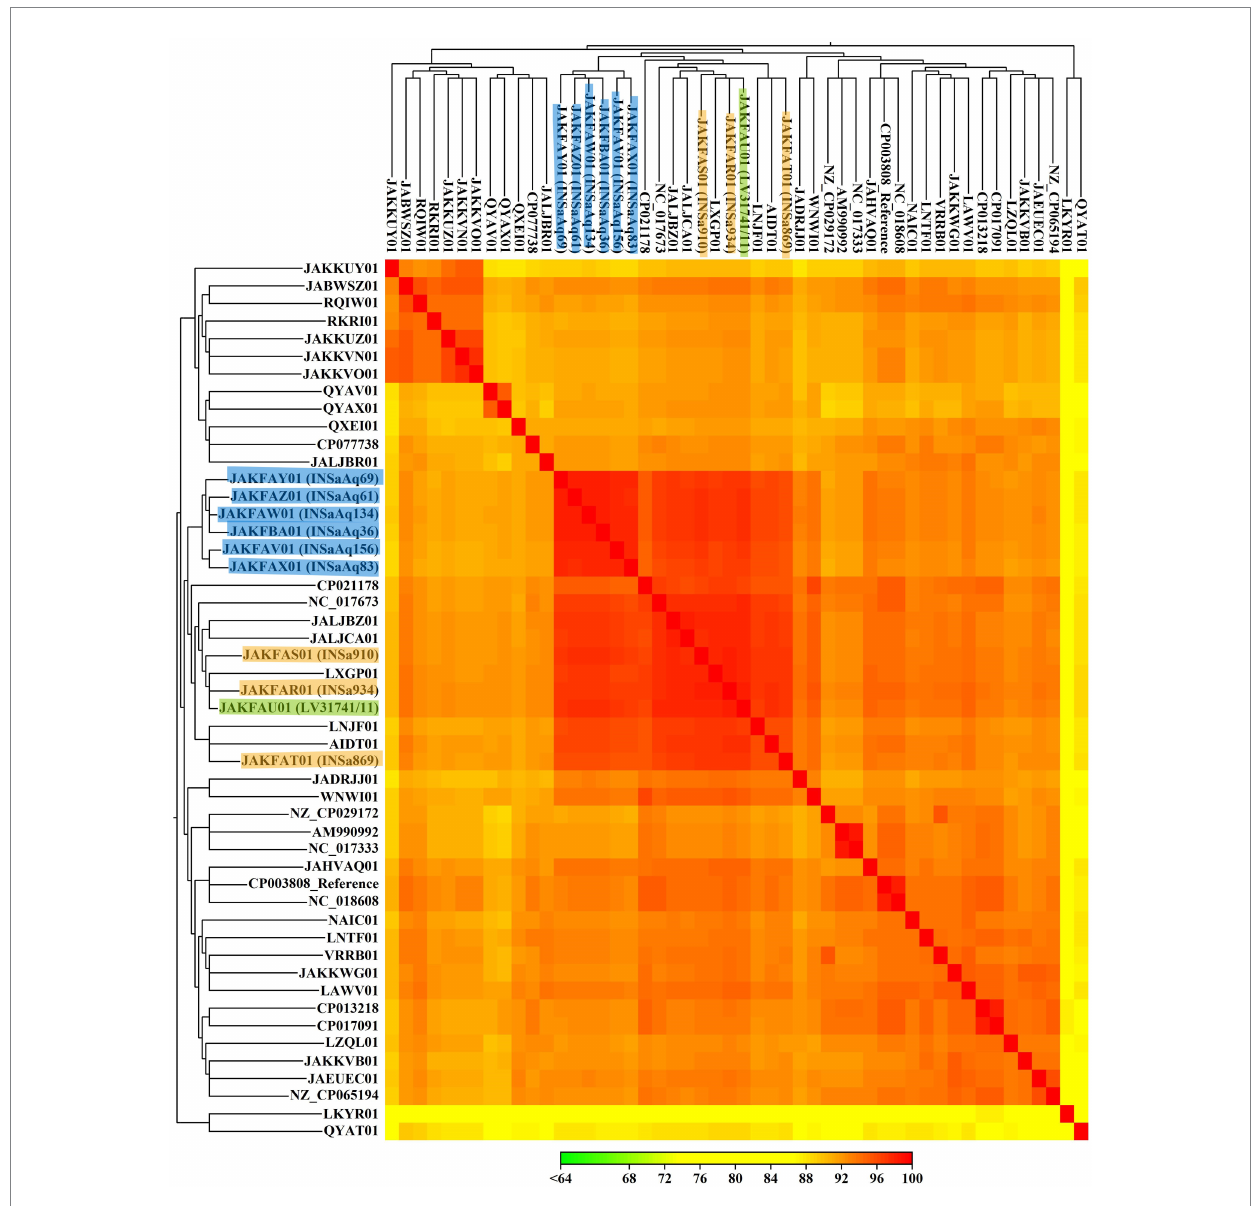
FIGURE 2 Heat map representing the alignment percentage (AP) between 50 S. aureus ST398 strains (10 from our study and 40 from NCBI database; Supplementary Table S1), constructed with CLC Genomics Workbench version 21.0.3, using Euclidean distance and complete linkage parameters. S. aureus from this study are highlighted according to the origin of the samples (humans in orange, dolphin in green and seabream from aquaculture in